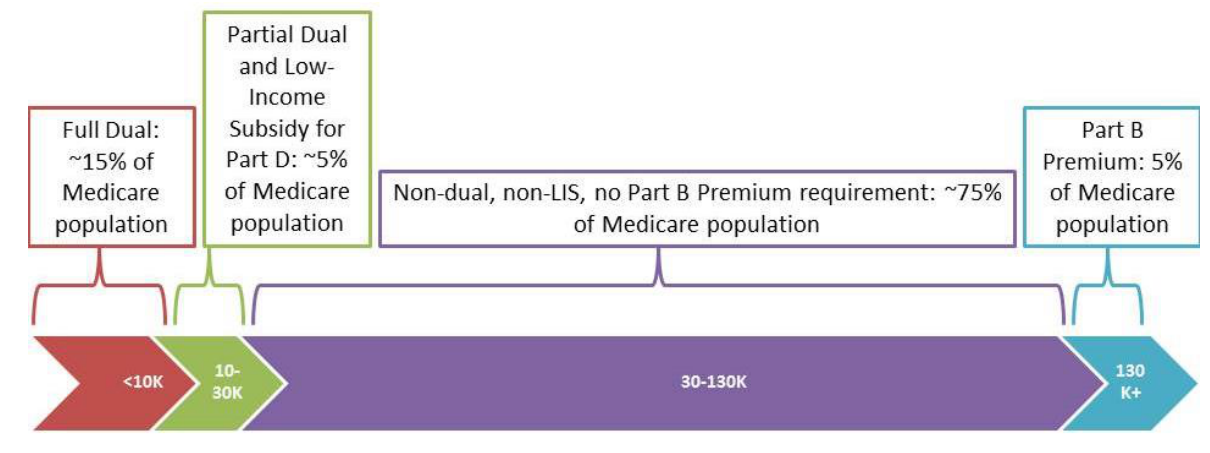
Figure 2.1: Individual-level Income Data in